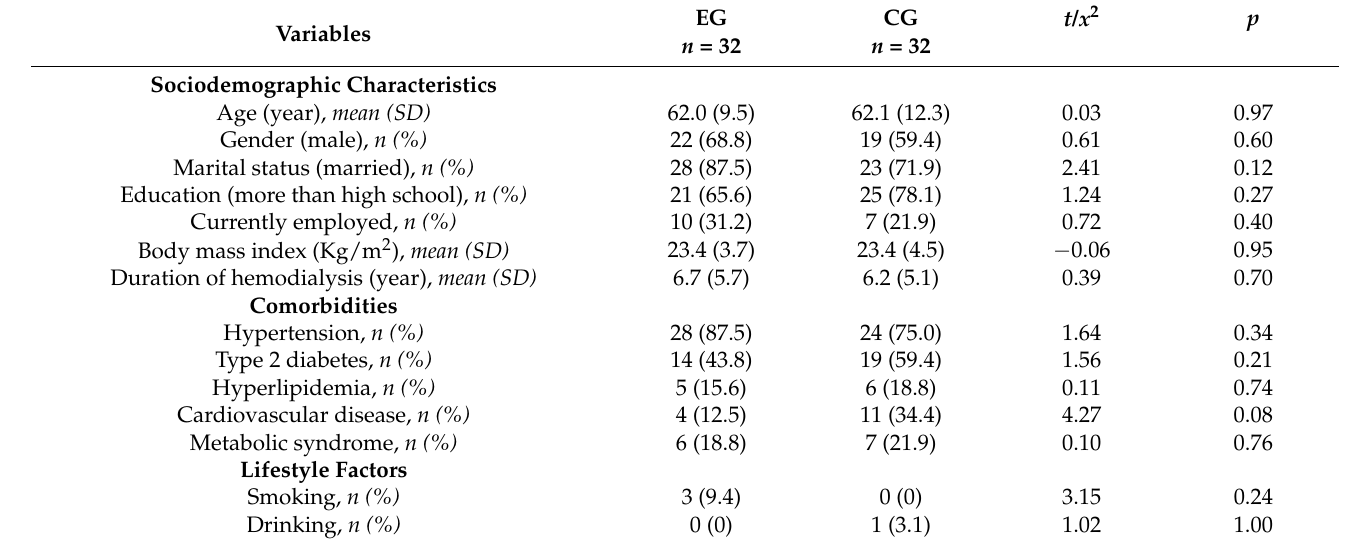
Table 1. Comparisons of demographics and comorbidity characteristics between